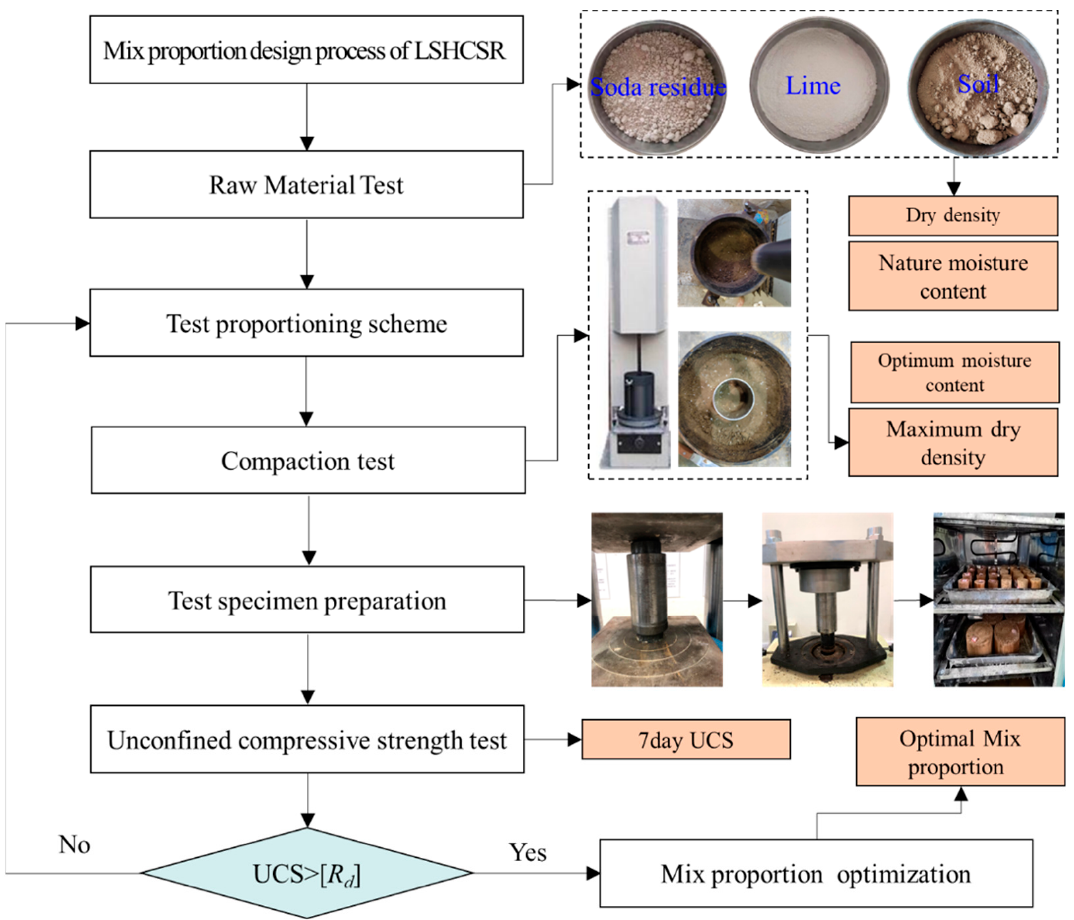
Figure 3. The mixing ratio design process.